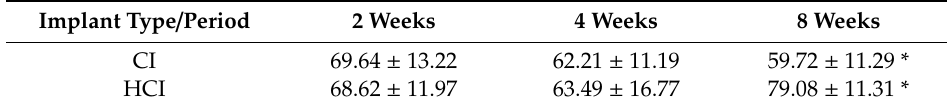
Figure 9. Histological images representative of the non-decalcified sections of the implants with different macrostructures and in different experimental periods. CI: Cylindrical Implant and HCI: Hybrid Conical Implant. Both in the periods of 2, 4 and 8 weeks. 5× and 10× magnification.